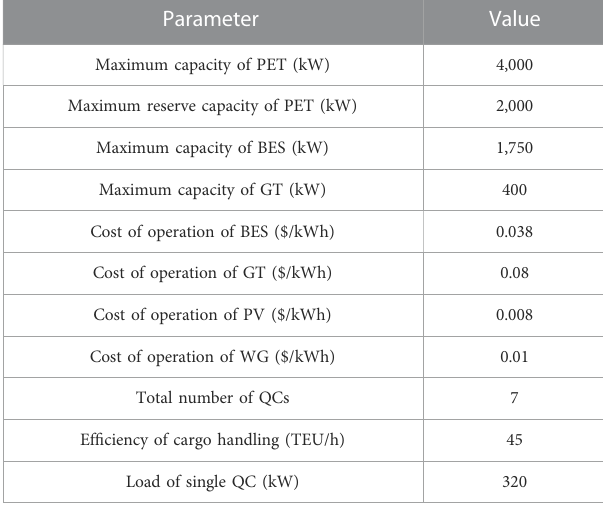
TABLE 1 Parameters of the green